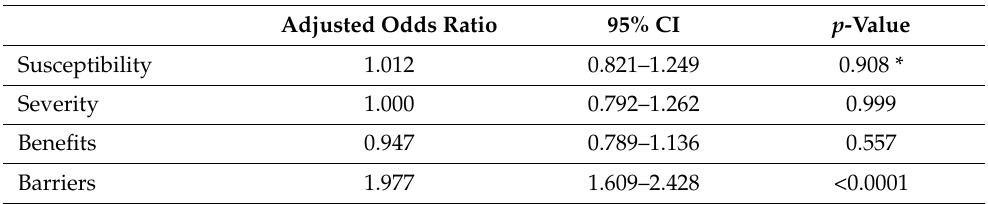
Table 4. Health Belief Model Components and Exercise Behavior Change: Ordinal Logistic Regres- sion